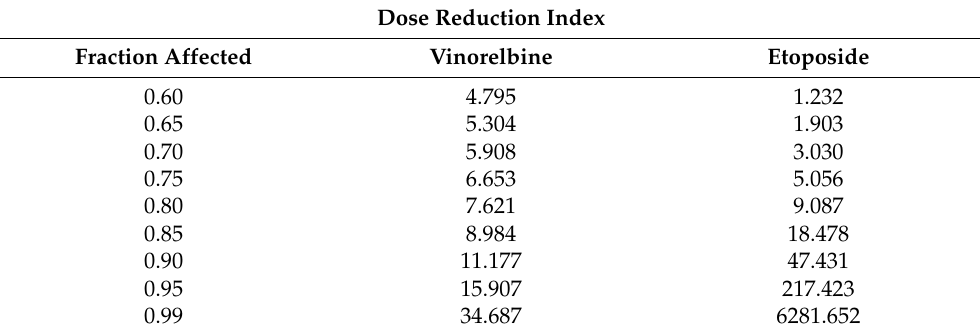
Table 1. Dose reduction index (DRI) values of Vinorelbine and Etoposide for fraction affected (Fa) of OCI-LY3 cell proliferation ranging from 0.60 to 0.99. The concomitant combination treatment of vinorelbine and etoposide was administered at the molar ratio of 1:100 for 144 h. The DRI defines the degree of dose reduction that is possible in combination for a given degree of effect as compared with the concentration of each drug alone.